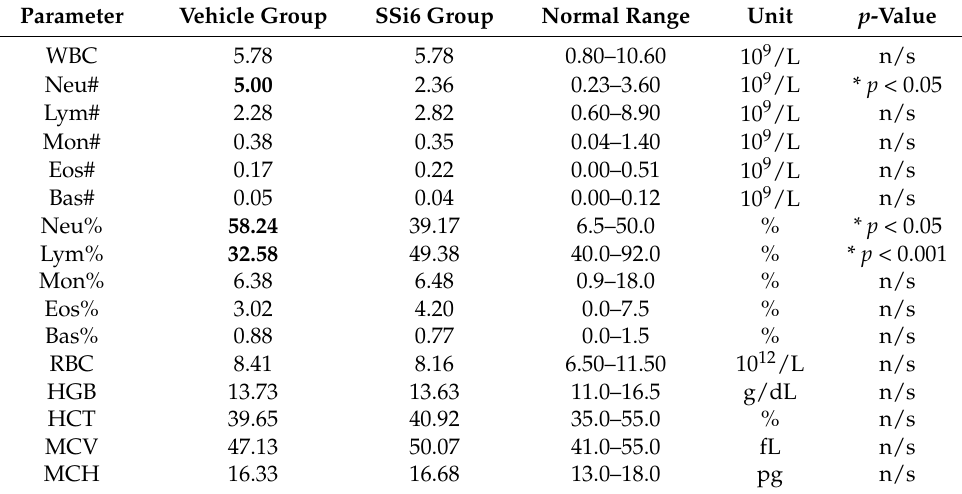
Table 2. Hemogram of mice for each group. Altered values are highlighted in bold. p -values